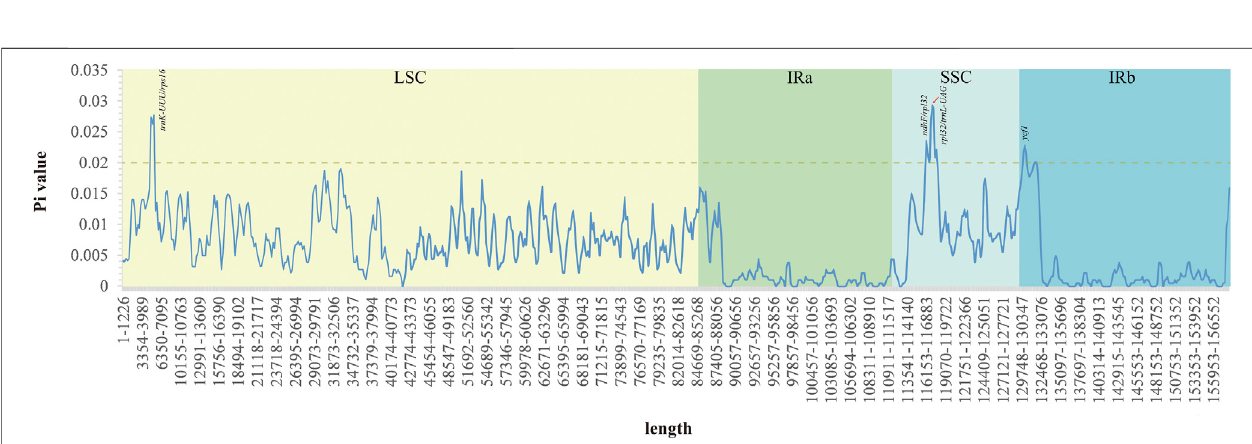
FIGURE6| Nucleotidevariabilityacrossthecpgenomesofthe fi ve Acer speciesstudied.Thehighestvalueswereannotatedbasedonthelocalizationofpredicted genes of the A. ukurunduense cp genome.